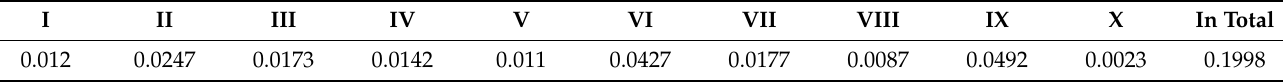
Table A7. Results by items (PFL&R Area).